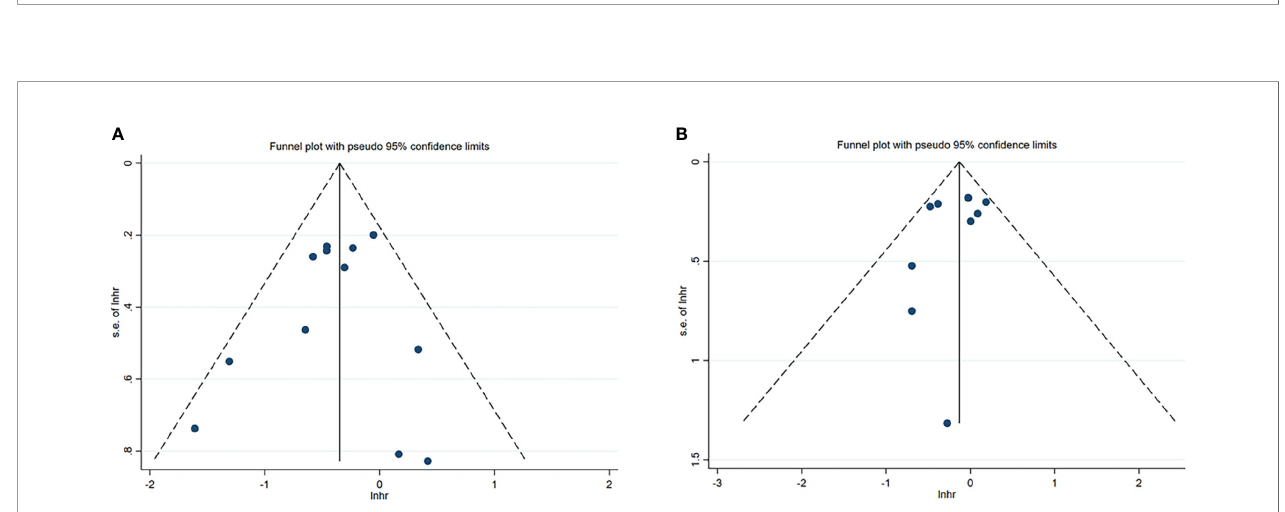
FIGURE 3 | Funnel plots of NK cells in HCC. (A) Funnel plots of HR for OS of NK cells. (B) Funnel plots of HR for DFS/RFS/TTR/PFS of NK cells. CI, Con fi dence interval; HR, Hazard ratio; HCC, Hepatocellular carcinoma; NK, Natural killer; OS, Overall survival; DFS, Disease-free survival; RFS, Recurrence-free survival; TTR, Time-to recurrence; PFS, Progression-free